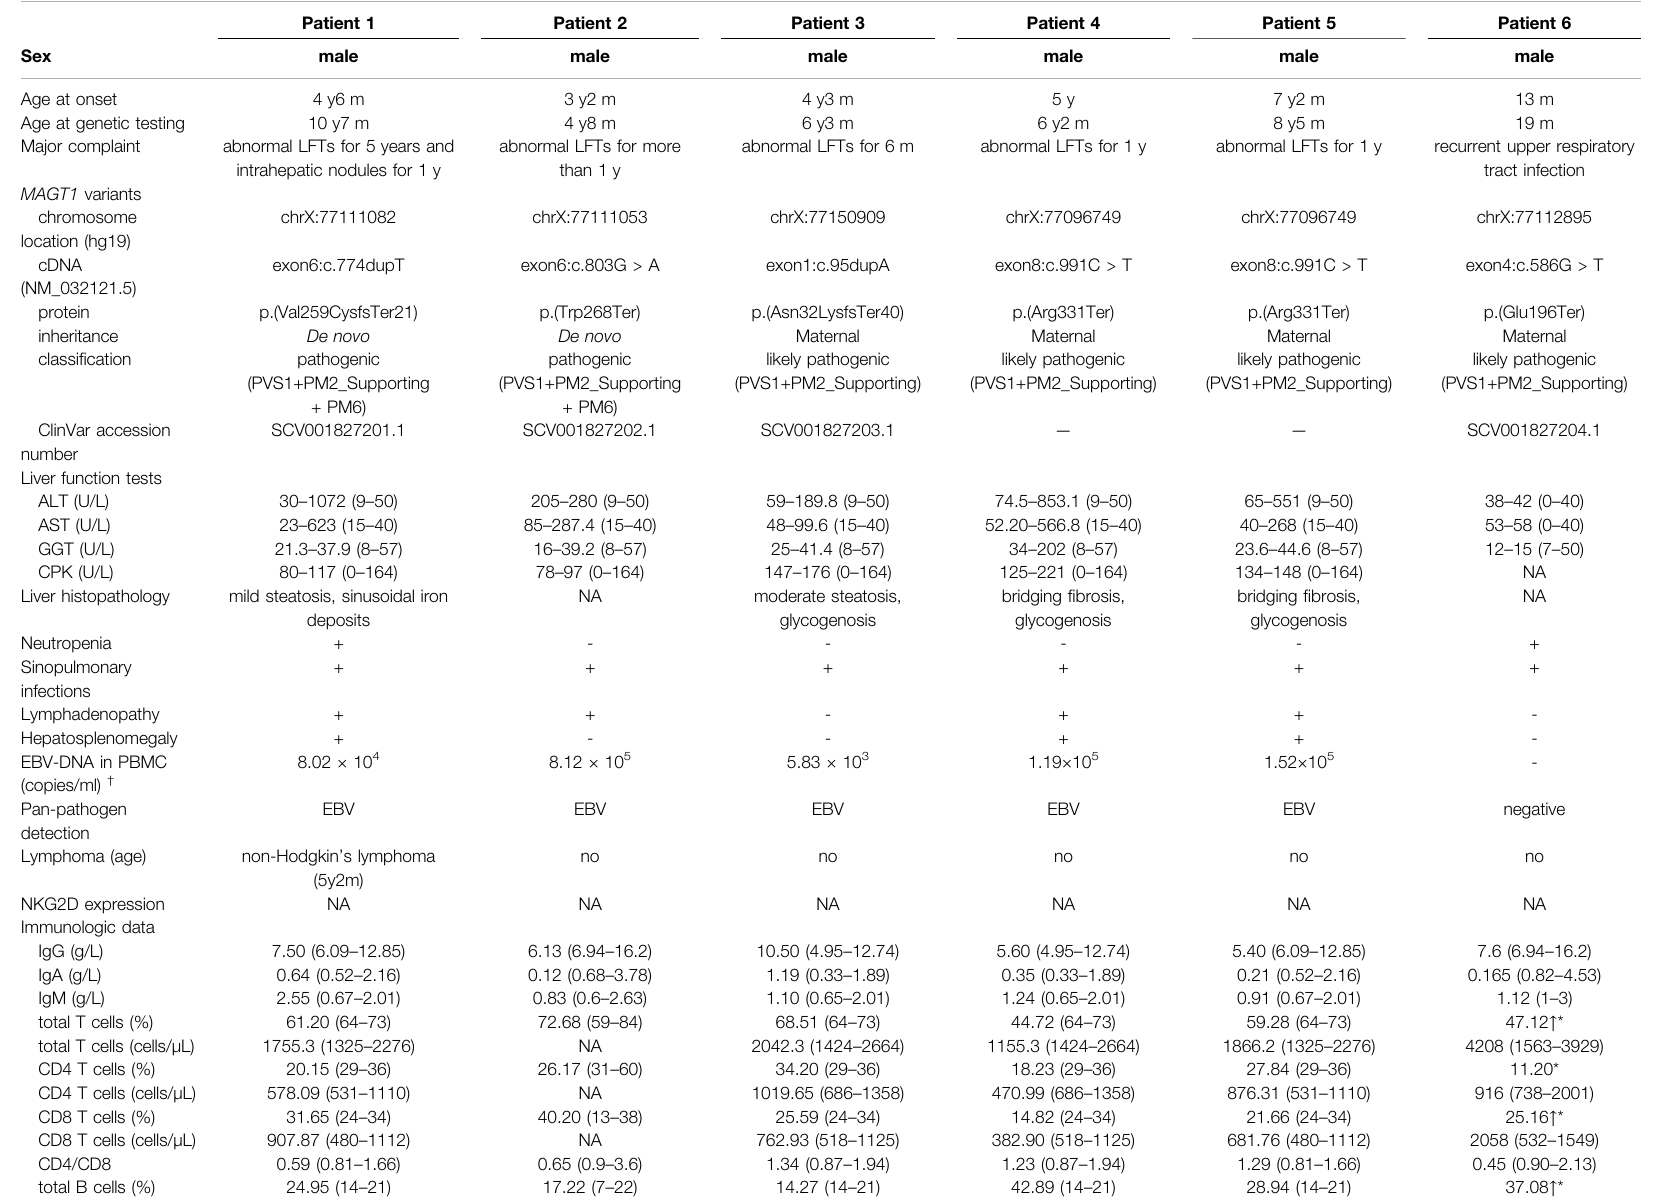
TABLE 1 | Clinical and genetic characteristics of six XMEN patients in this